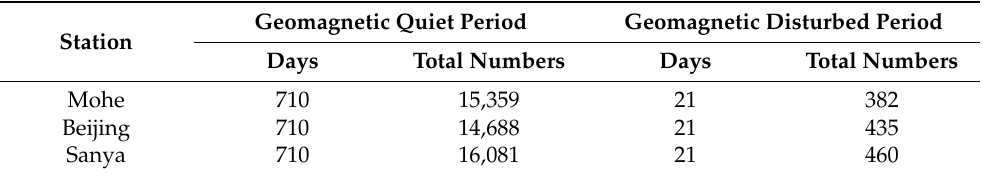
Table 1. The total number of available ionosondes of foF2 during geomagnetic disturbed/quiet days in the years 2014 and 2016 at Mohe, Beijing and Sanya over China.